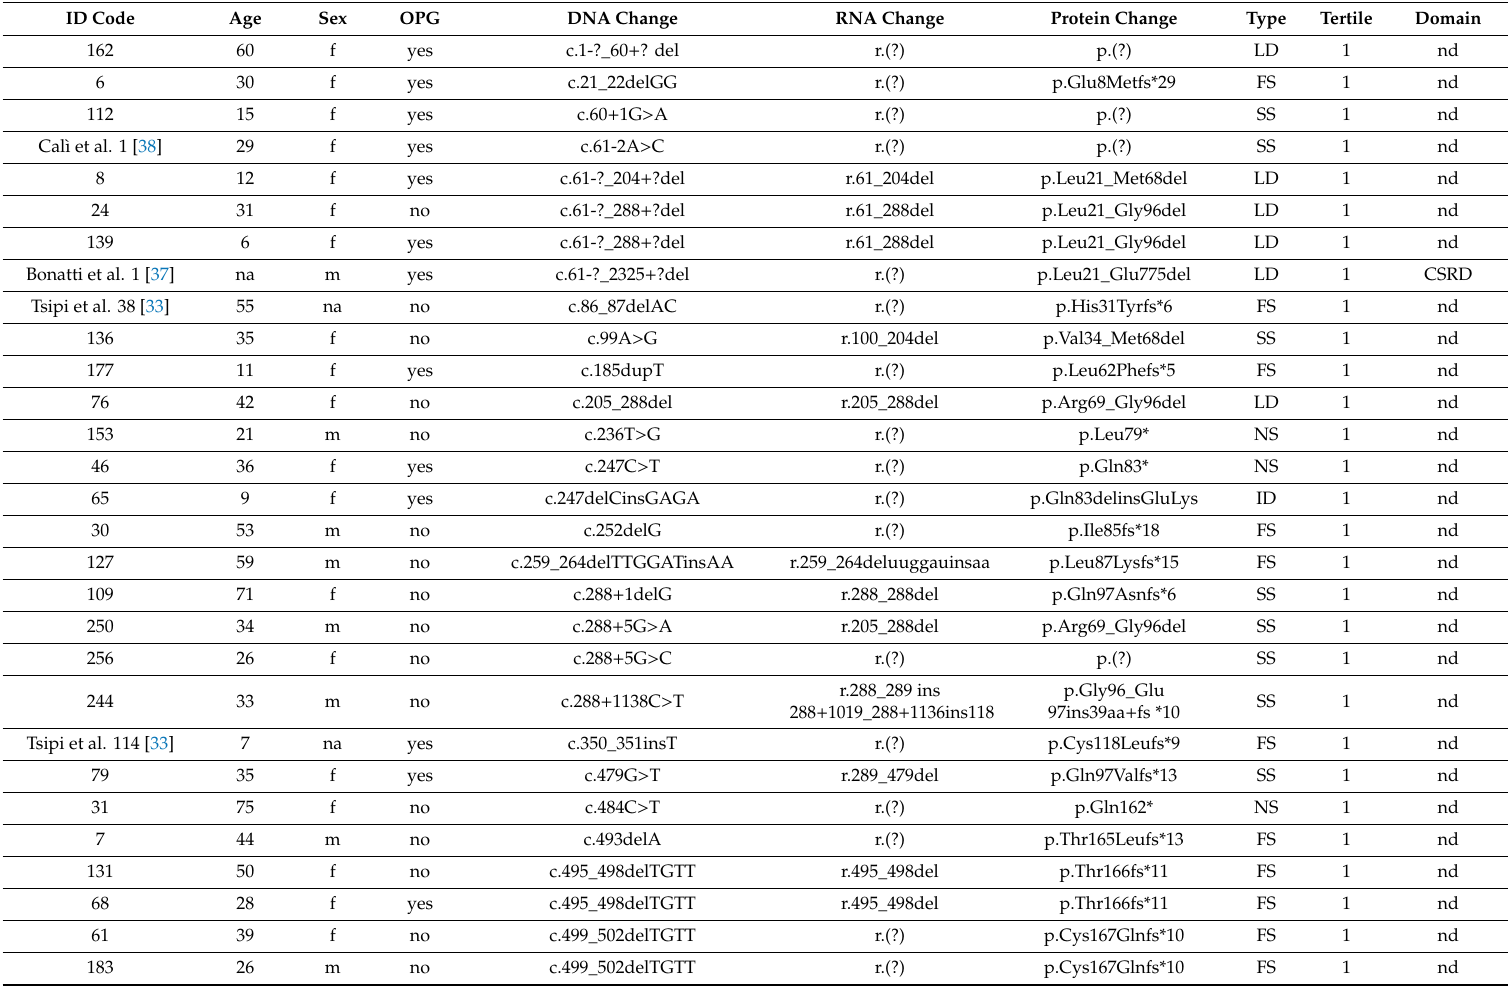
Table 1. Clinical data, molecular details, mutation type, and mutation location by tertile and